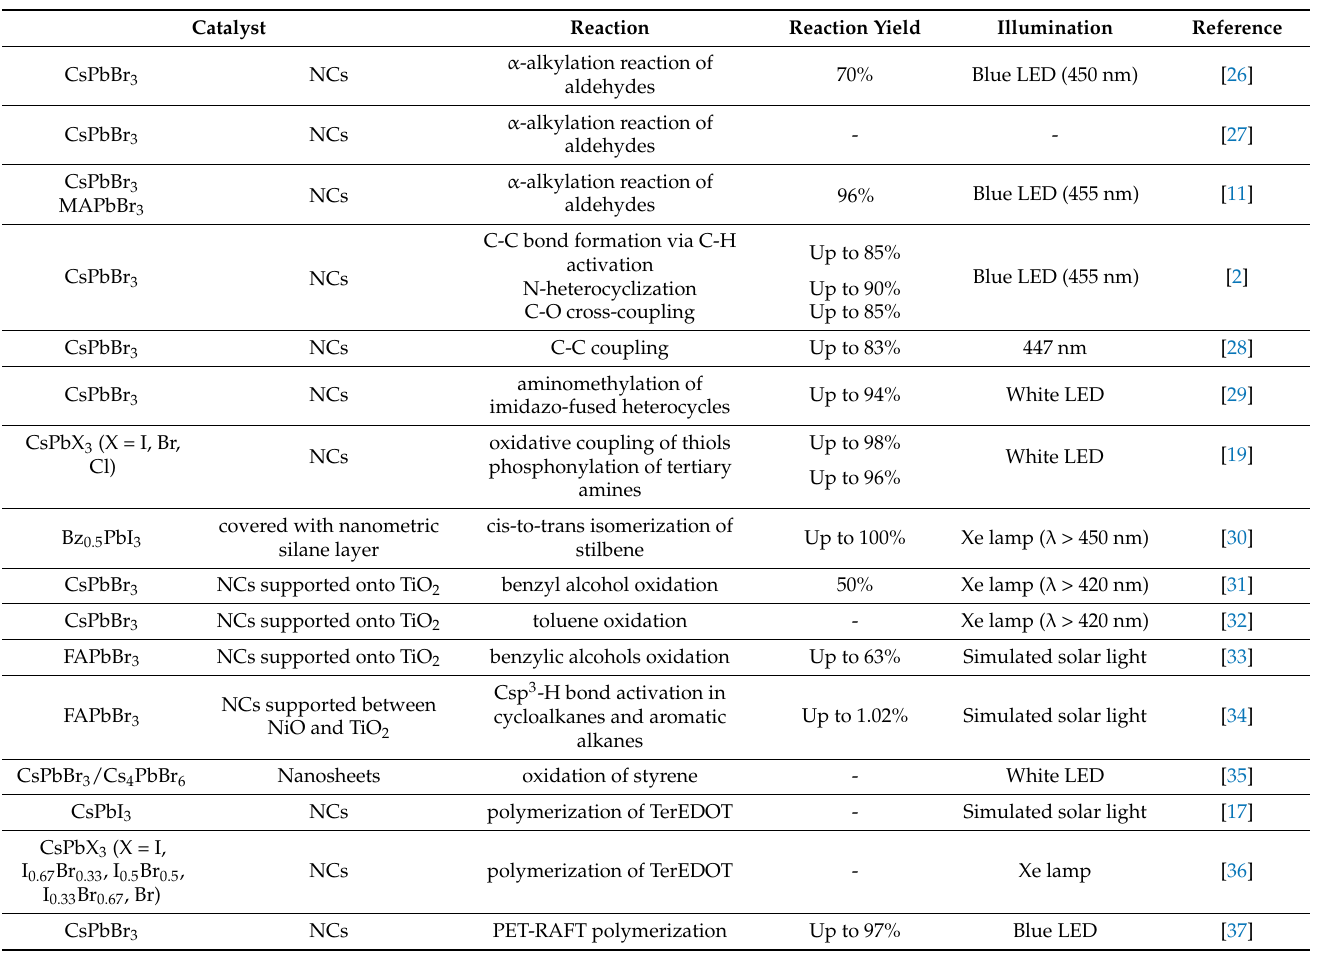
Table 1. Nanocrystalline Pb-based photocatalytic systems reviewed in the present paper highlighting the reaction, the reaction yield, and illumination means.